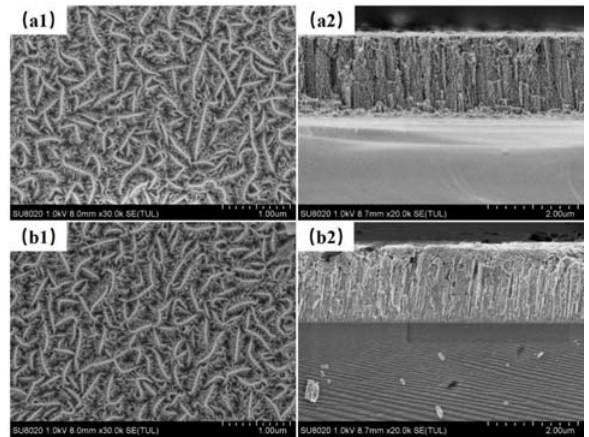
Figure 3. Surface and cross ‐ section micrographs of pure MoS 2 ( a1 ), ( a2 ); MoS 2 –WS 2 composite film ( b1 ), ( b2 ).